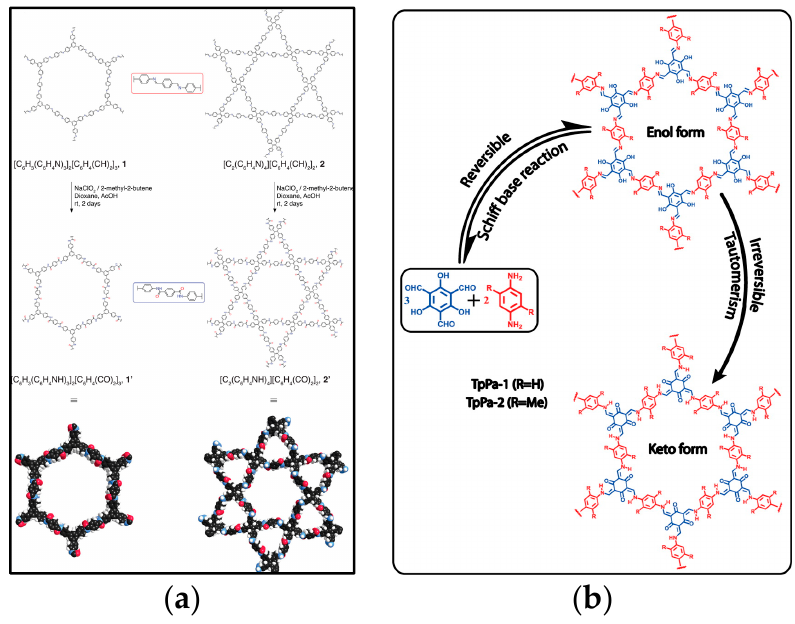
Figure 3. Schematic representations of conversion from imine bonds to amide bonds ( a ) and from enol-imine form to keto − enamine form ( b ). ( a ) was reprinted with permission from [98]. American Chemical Society, 2016; ( b ) was reprinted with permission from [99]. American Chemical Society, 2012.